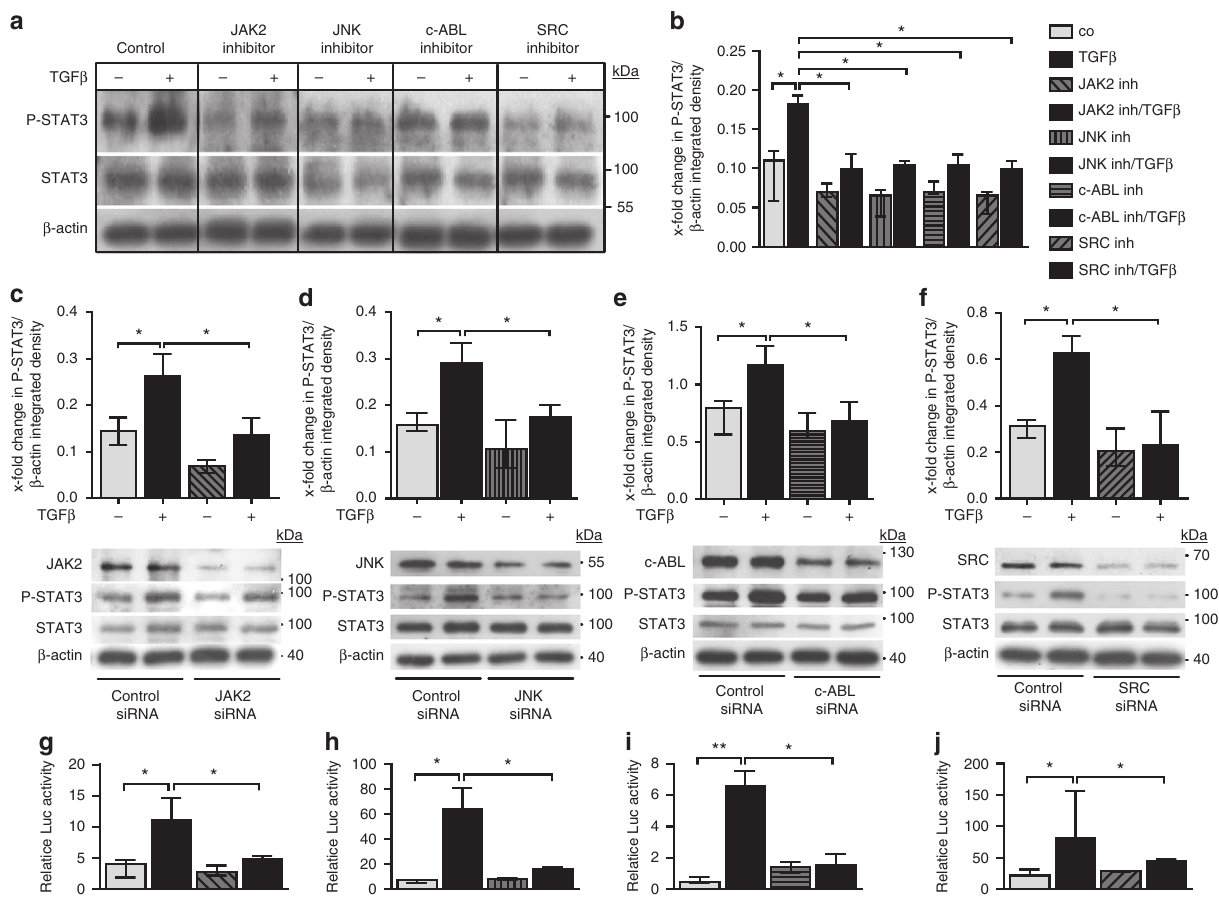
Fig. 4 Pro fi brotic kinases pathways converge on P-STAT3 in vitro. a , b Effects of pharmacologic inhibition of JAK2, JNK, c-ABL, and SRC kinases on the levels of P-STAT3 in TGF β -stimulated fi broblasts in vitro as analyzed by a western blot and b its quanti fi cation ( n ≥ 4 with 2 technical replicates per condition for all experiments). Representative images and quanti fi cation of four independent experiments are shown. c – f Effects of siRNA-mediated knockdown of c JAK2, d JNK, e c-ABL, and f SRC, respectively, on levels of P-STAT3 in healthy human dermal fi broblasts stimulated with TGF β , as shown by representative western blots and quanti fi cations ( n ≥ 4 with 2 technical replicates per group for all experiments). JAK2 (expected molecular size, 132 kDa), JNK (expected molecular size, 49 and 55 kDa), c-ABL (expected molecular size, 125 – 135 kDa), and SRC (expected molecular size, 60 kDa) are represented by ladders showing 100, 55, 130, and 70 kDa, respectively. Beta-actin expected molecular weight/size is 42 kDa. g – j Relative luciferase activity in fi broblasts transfected with STAT3 luciferase reporter plasmid and treated with g the JAK2 inhibitor TG101209, h the JNK inhibitor SP600125, i the c-ABL inhibitor imatinib mesylate and j the SRC inhibitor SU6656, independently with or without TGF β stimulation ( n = 3 independent experiments with 2 technical replicates per group for all experiments). Luciferase activity was normalized against a non-inducible luciferase construct. Results are shown as median ± interquartile range (IQR). Signi fi cance was determined by Mann – Whitney test, as compared to untreated unstimulated fi broblasts or untreated TGF β -stimulated fi broblasts, respectively. * P < 0.05; ** P < 0.01, *** P < induced skin fi brosis and TBRact-induced skin fi brosis. Indivi- dual inhibition of JAK2, JNK, SRC, or c-ABL signaling all signi fi cantly ameliorates the bleomycin-induced accumulation of P-STAT3 (Fig. 5a – c). Consistently, treatment with small molecule inhibitors of either JAK2, JNK, SRC, or c-ABL all reduces the accumulation of phosphorylated STAT3 in mice overexpressing TBRact (Supplementary Fig. 2). However, despite relatively high doses of each inhibitor, none of the treatments completely abrogates the activation of STAT3 signaling by bleomycin. These data demonstrate that the activation of STAT3 in activated fi broblasts results from the combined activation of JAK2, JNK, SRC, and c-ABL kinases.